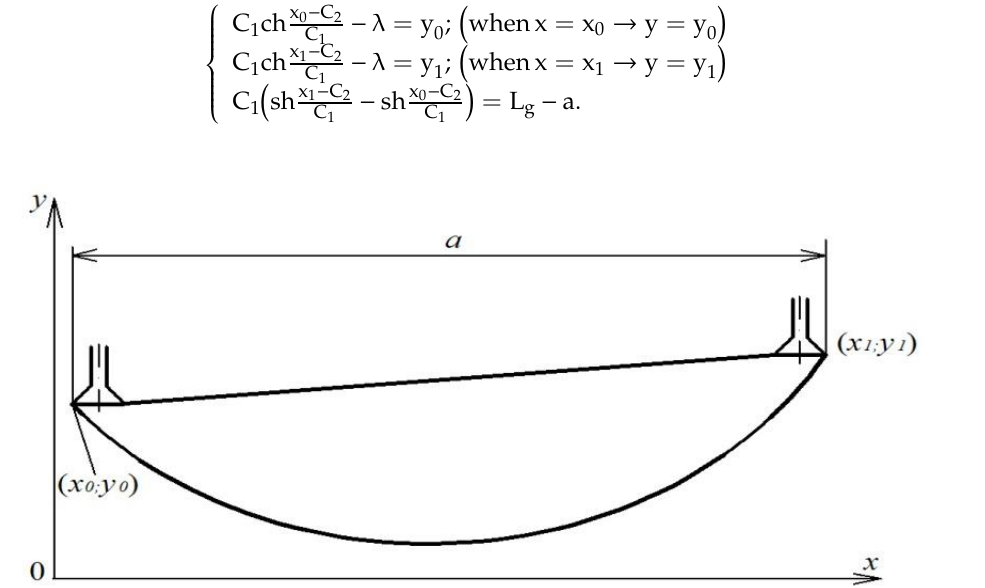
Figure 3. General case of holding of the flexible container (FC).